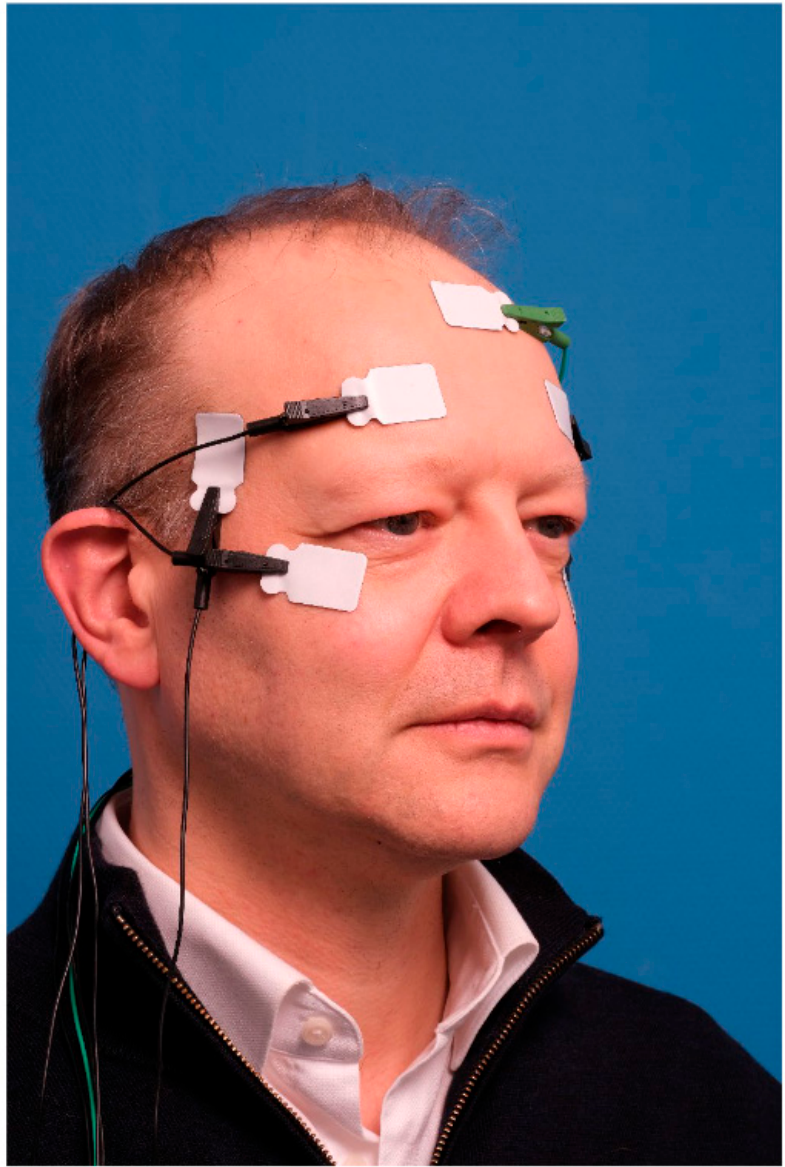
Figure 4. Photograph of EMG placement.